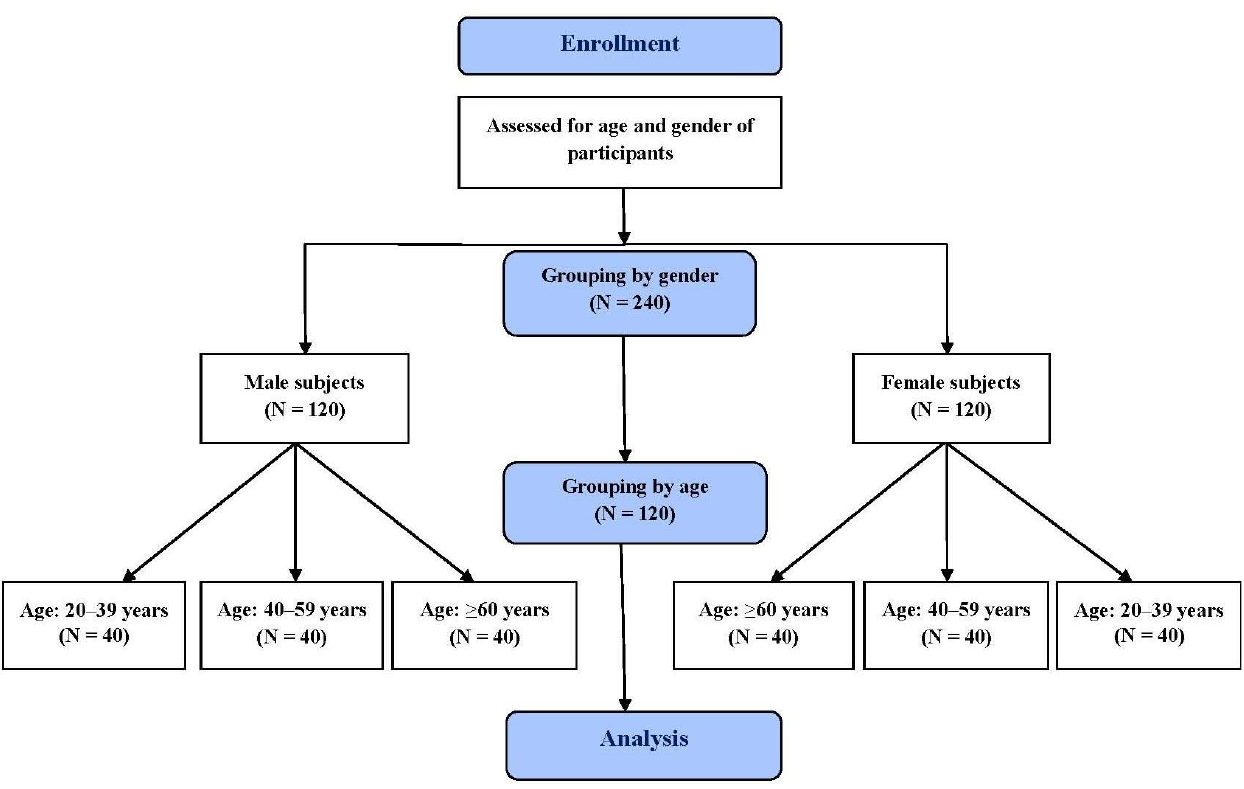
Figure 1. Participant flow